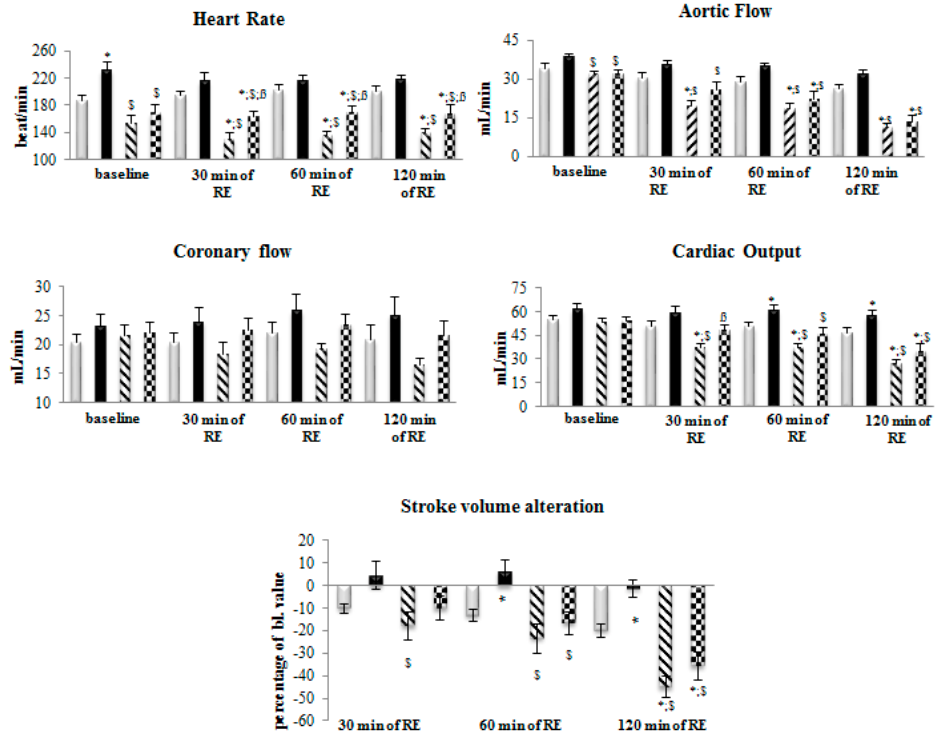
Figure 2. Effect of postischemic reperfusion on function of isolated working hearts from rats treated with bitter melon (BM) extract. Lean or Zucker Obese rats ( n = 10 animals in each group), fed daily by gavage, for six weeks at 400 mg/kg body weight of BM, are sacrificed and thoracotomized, followed by mounting on isolated working heart setup. Hearts were subjected to 30 min of ischemia followed by 120 min of reperfusion. Cardiac functions including heart rate (HR), aortic flow (AF), coronary flow (CF), cardiac output (CO) and stroke volume alteration (devSV) were recorded before ischemia at time points of 0 (baseline), and 30, 60 and 120 min of reperfusion. Results are provided as average magnitude of each cardiac function value within a group of animals ± SEM. Significance level of difference between average outcome values shown in histograms, is p < 0.05, or less, indicated as follows: * p < 0.05 versus Lean control values; $ p < 0.05 versus Lean BM values; ß p < 0.05 versus ZO